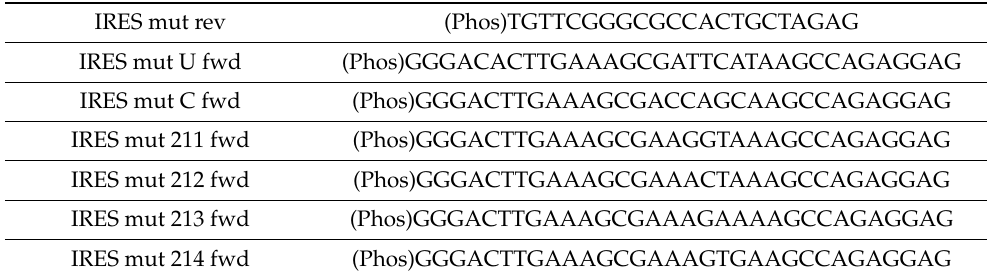
Table 1. List of primers used to generate IRES